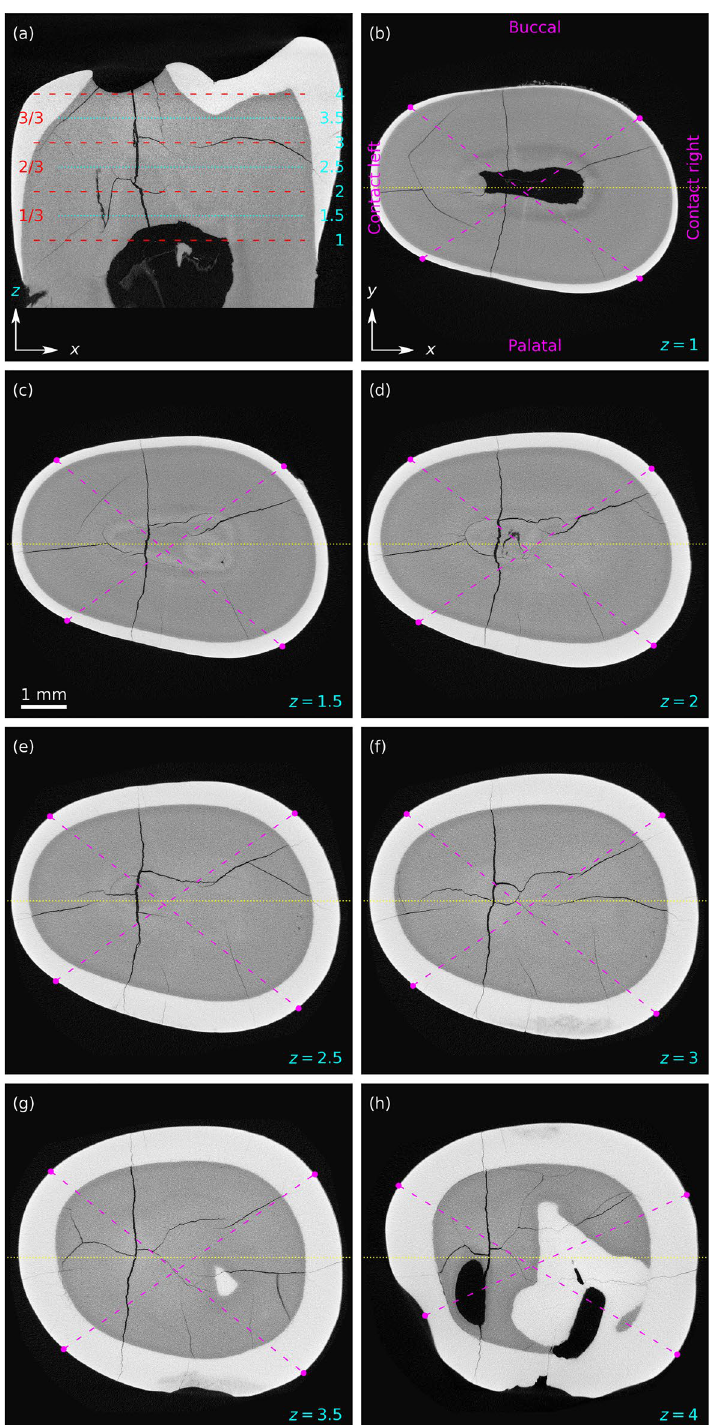
Figure 2. X-ray µ CT data-cube cuts of a tooth without visible enamel microcracks on the buccal surface. Enamel is light-grey, dentin—dark-grey, and tooth outside, pulp and cracks—black. ( a ) Vertical slice in x , z plane at y position, as indicated by horizontal dotted yellow line in panels ( b – h ). ( a ) Horizontal dashed red 1 4 of slices in x , y planes, displayed as images in panels ( b – h ). ( a ) and dotted cyan lines show positions z = − Horizontal slabs selected between dashed red lines are indicated as 1/3, 2/3, 3/3. In panels ( b – h ) dashed magenta lines cut-out four identified sectors (buccal, contact right, palatal, contact left). Field of view is One pixel corresponds to 10 µ m ∼